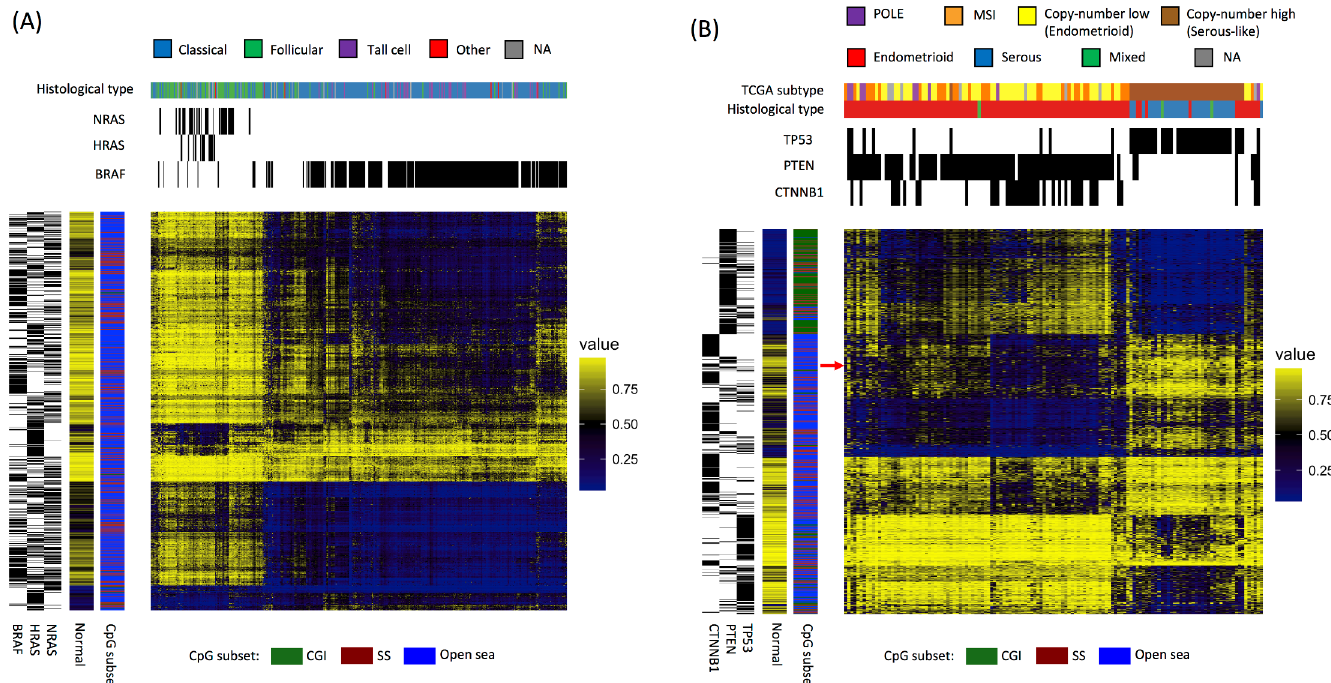
Fig 4. Driver gene–associated methylation patterns can be used to identify tumor molecular subtypes. Heat maps for (A) thyroid carcinoma (THCA) and (B) uterine corpus endometrial carcinoma(UCEC) depict hierarchicalclusteringof methylationvalues of the union set of the 500 probes most significantly associated with each of the three dominant driver genesin each cancer type. Each column represents a sample, and each row represents a probe. Mutation status and subtype classification are shown in the upper sidebars.The sidebarson the left indicategene-probe associationsand CpG subsets, as well as averagemethylation levels across normal samples. The arrow in (B) indicatesmethylationprobes that display more hypomethylation in samples where PTEN and CTNNB1 mutations co-occur than in samples with PTEN mutations alone.